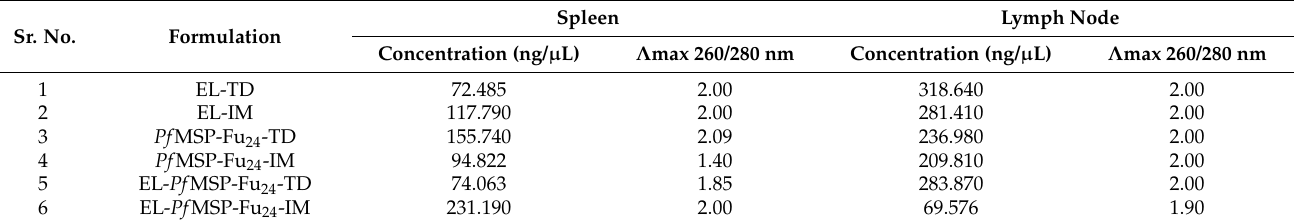
Table 2. RNA extracted from homogenized spleen and lymph